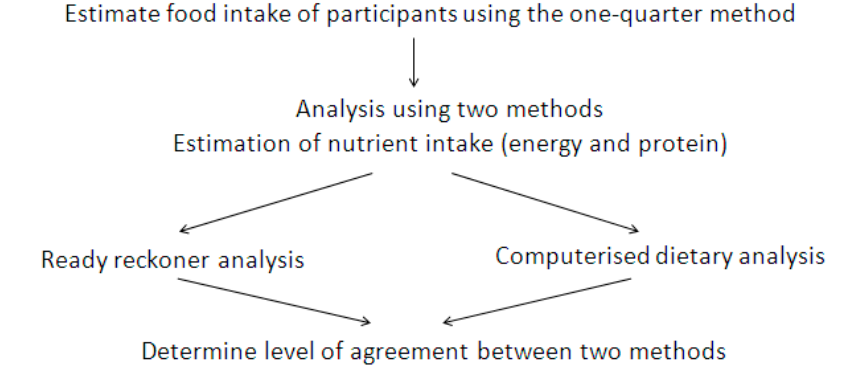
Figure 1. Flowchart of methods used to determine level of agreement in this study.